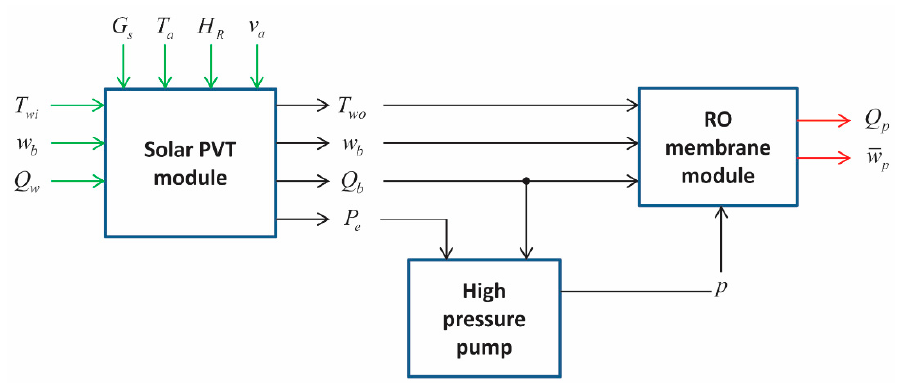
Figure 6. Schematic diagram of the PVT-RO system.